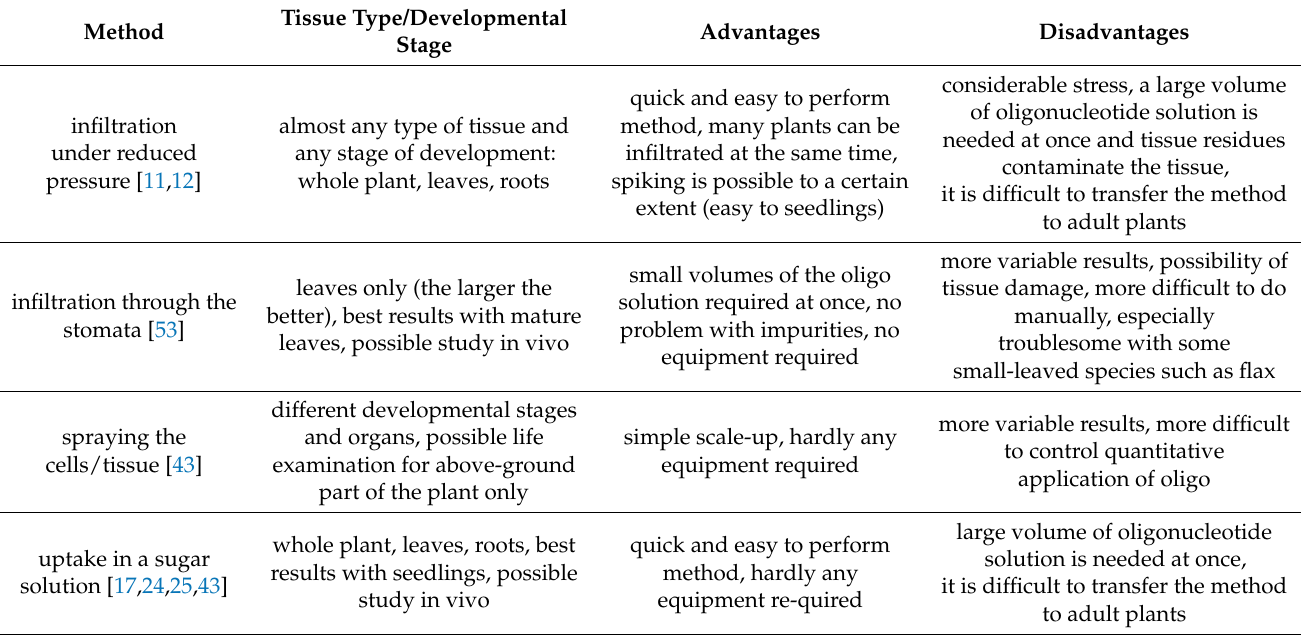
Table 1. Method for delivering an oligonucleotide to a plant